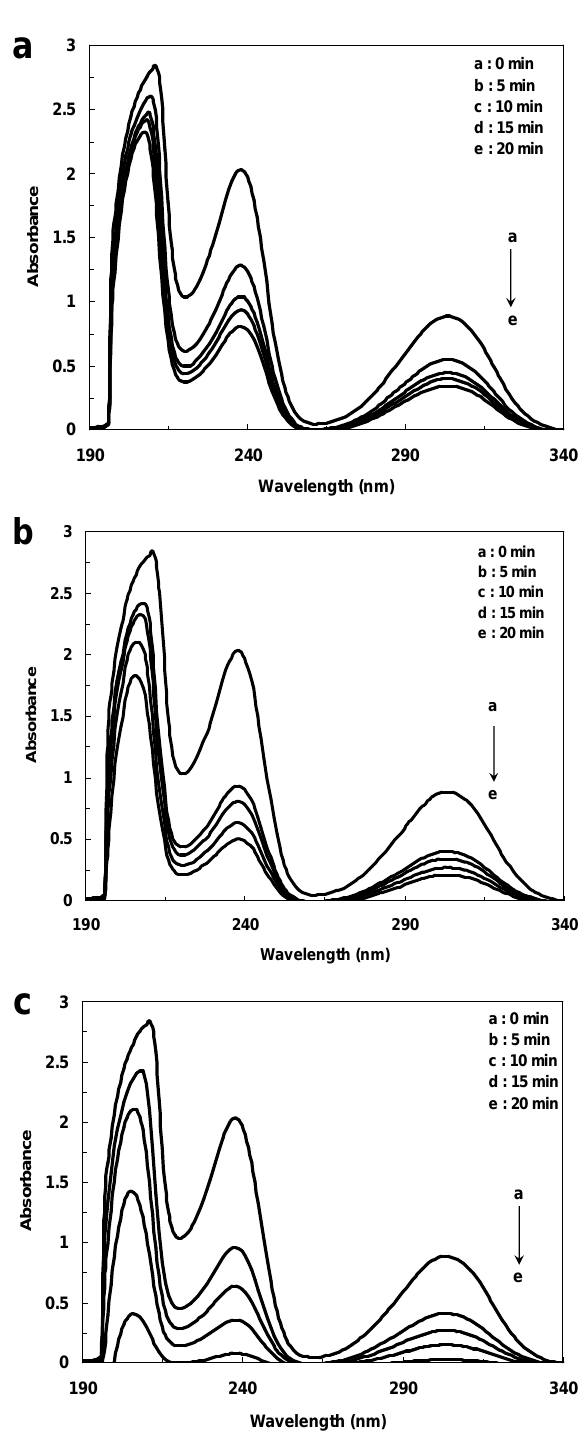
Fig. 4. UV-Vis absorbance spectra during the photo-catalytic degradation of salicylic acid using: (a) TiO 2 nanotubes prepared in one-step anodization process, (b) TiO nanotubes prepared in 2-step 2 anodization process and (c) TiO nanotubes prepared in 2-step anodization process with the UV 2 pretreatment in